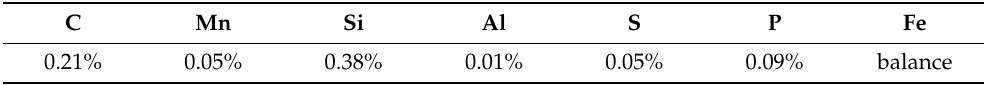
Table 5. Mild steel chemical composition